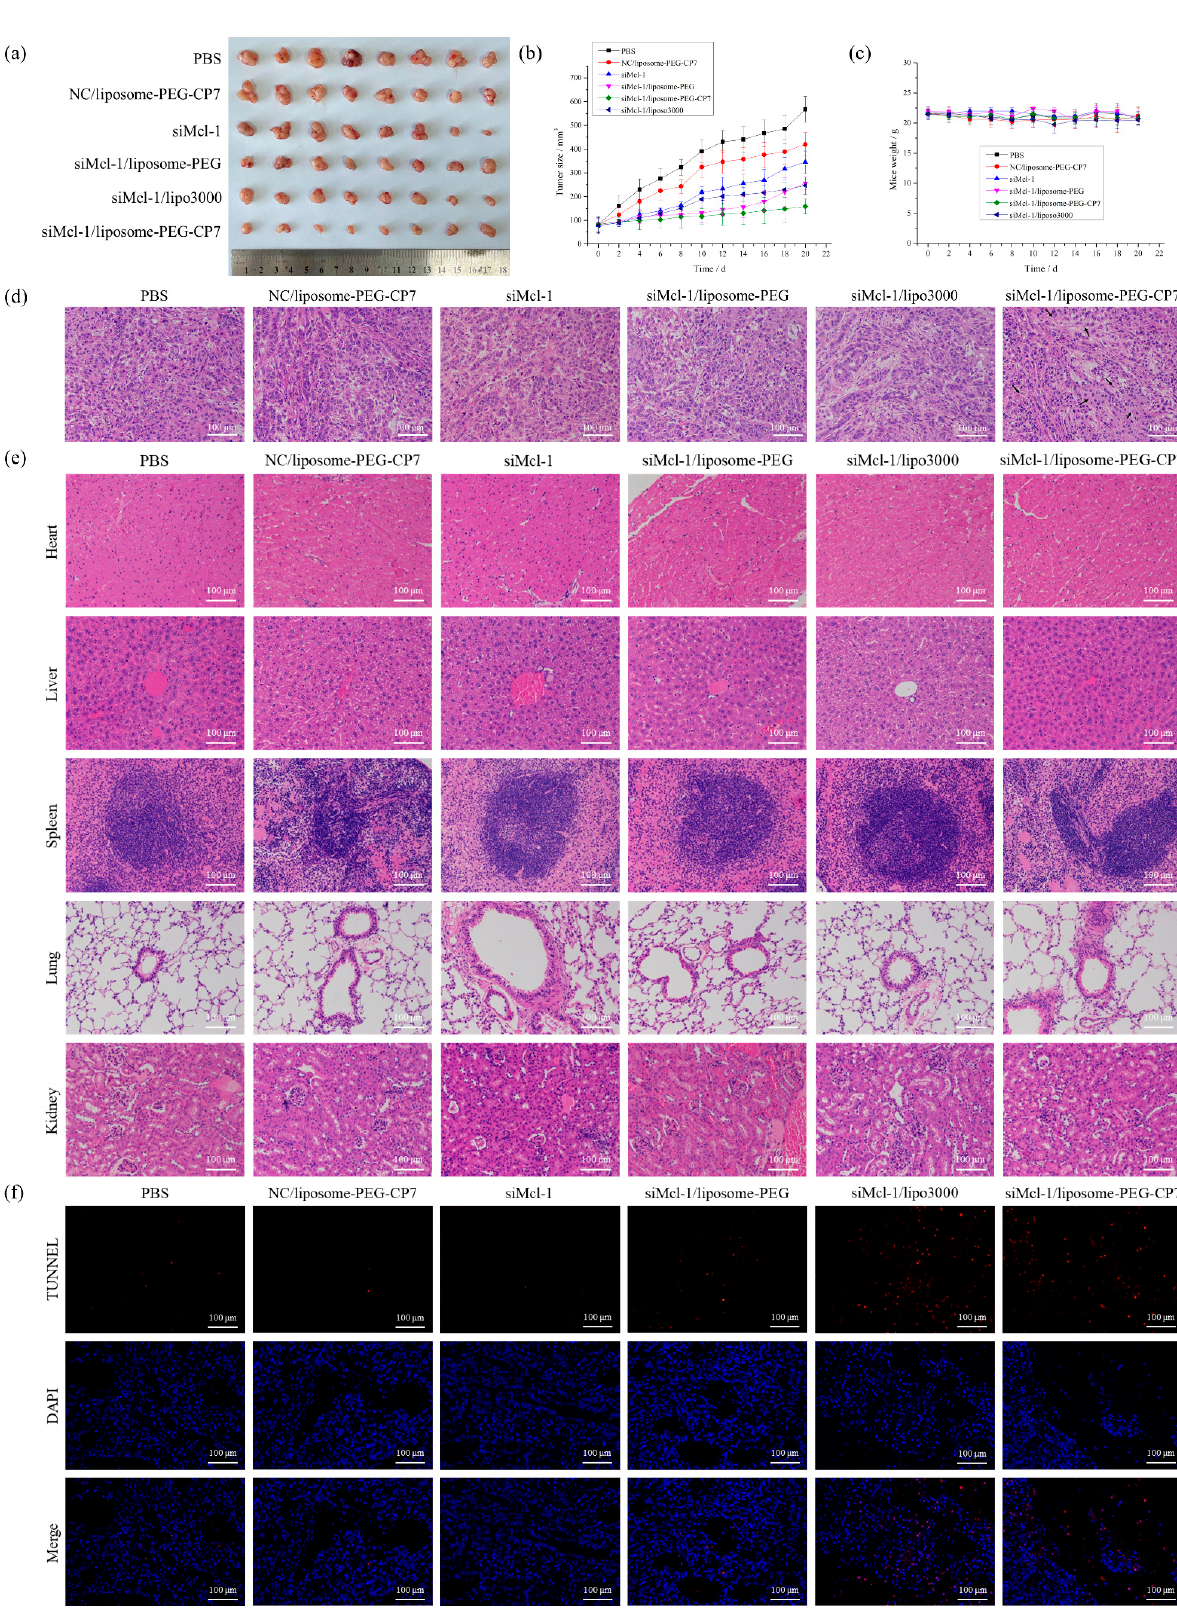
Figure 5. ( a ) Photo of tumor tissues from mice treated with PBS, siMcl-1/lipo3000, siMcl-1/liposome- PEG-CP7, siMcl-1/liposome-PEG, NC/liposome-PEG-CP7, and free siMcl-1 at the end of the